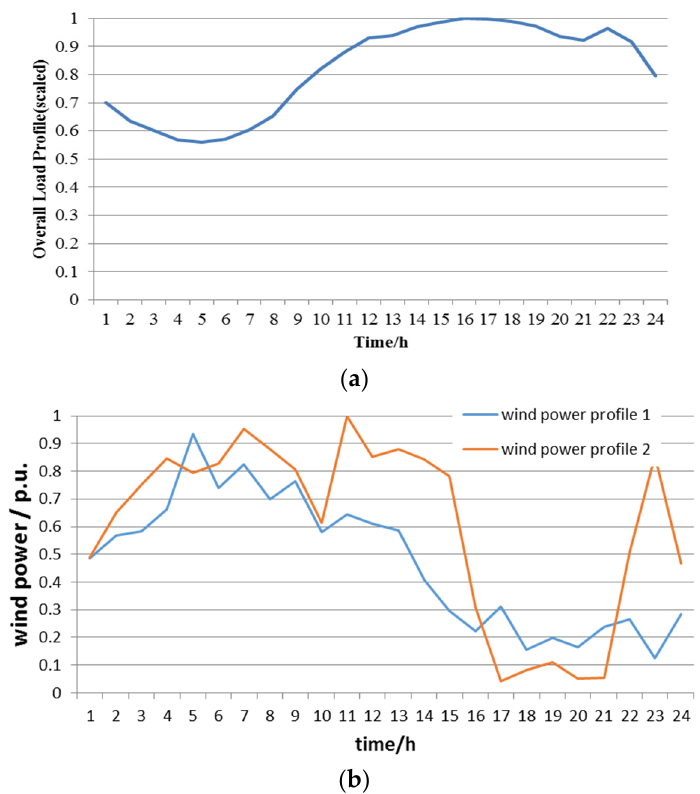
Figure 3. ( a ) Peak-normalized aggregate load benchmark; ( b ) Two kinds of peak-normalized wind power profiles respectively for three scenarios and five scenarios.